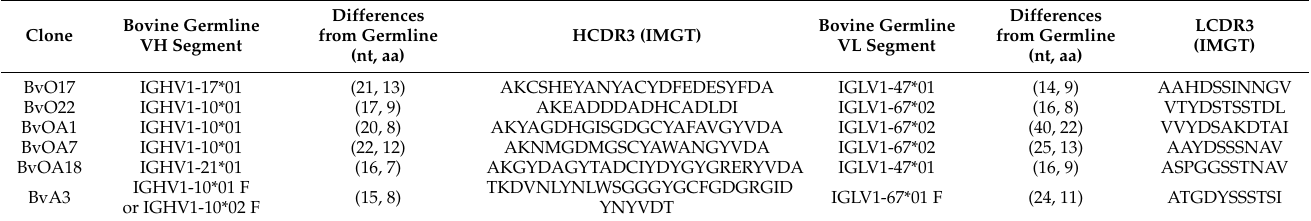
Table 1. Analysis of VH and VL gene usage in the selected scFv clones. The nucleotide sequences were analyzed using IMGT/V-QUEST (http://www.imgt.org/IMGT_vquest/input, last accessed December 2, 2020).